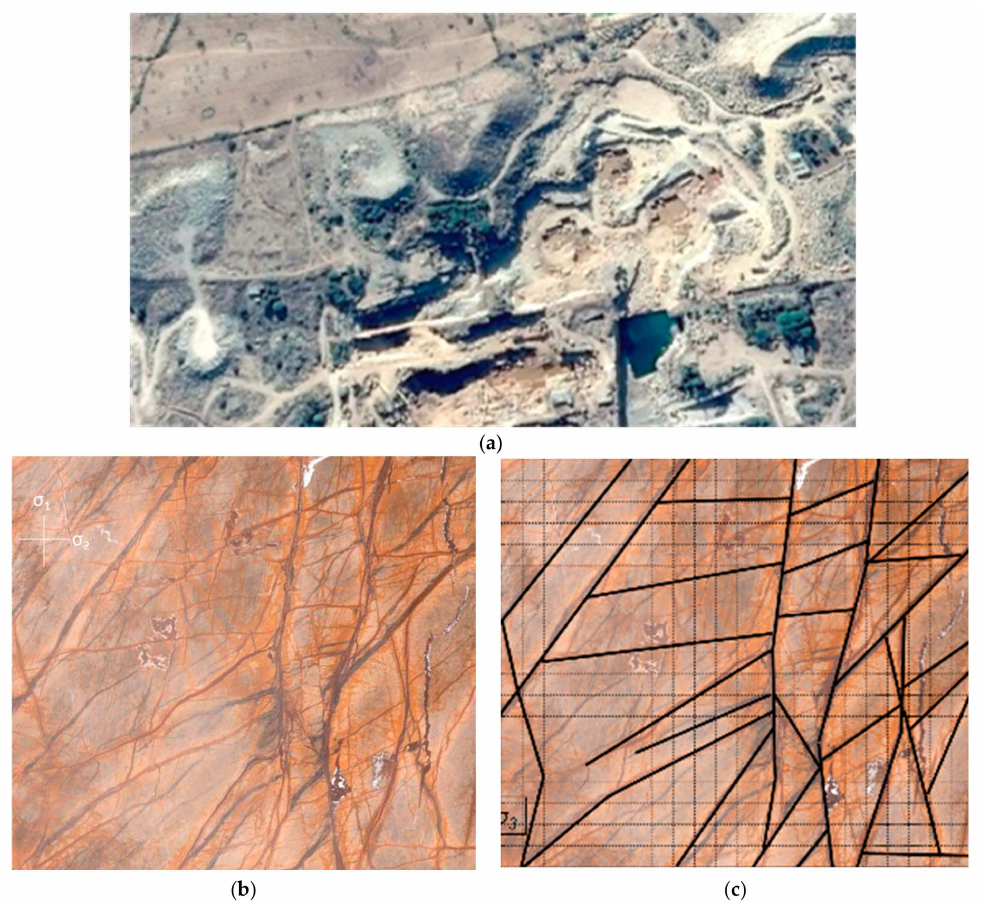
Figure 19. The images are sorted from the largest to the smallest from top row to bottom row. ( a ) Satellite image of the quarry near Bidasar, Rajasthan, India (roads for scale). North is downward in image (Google Earth composite of 16 December 2015). ( b ) Orthogonal photograph of polished rock slab with filled fracture veins. Image dimensions about 1 × 1 m. ( c ) Interpreted principal fracture network (black